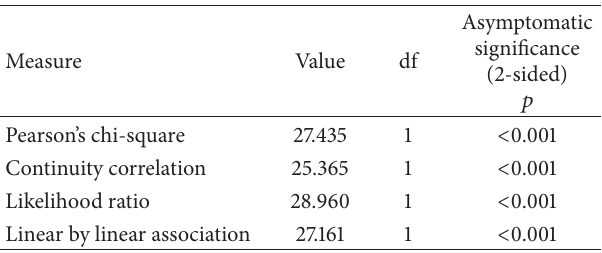
Table 1: Chi-square tests. Chi-square tests were computed for a 2 × 2 table; 0% of the cells had an expected count less than 5. Minimum expected count was 22.